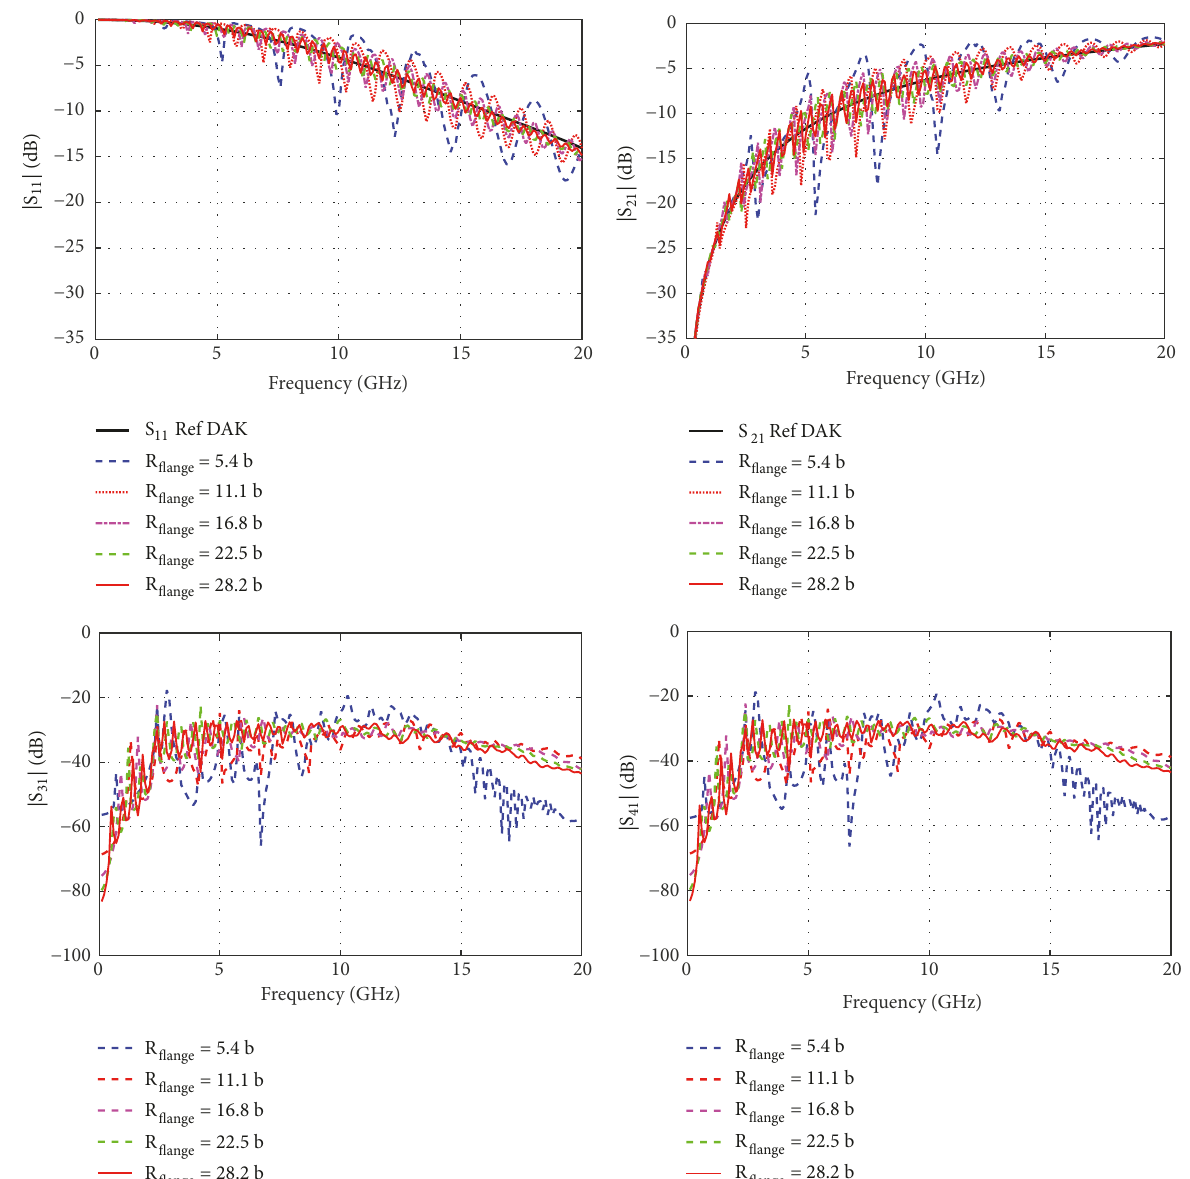
Figure 18: Magnitude (dB) of S 31 and S 41 for model B with TEM and TM 0 flange size (thickness d =1 mm, R sample